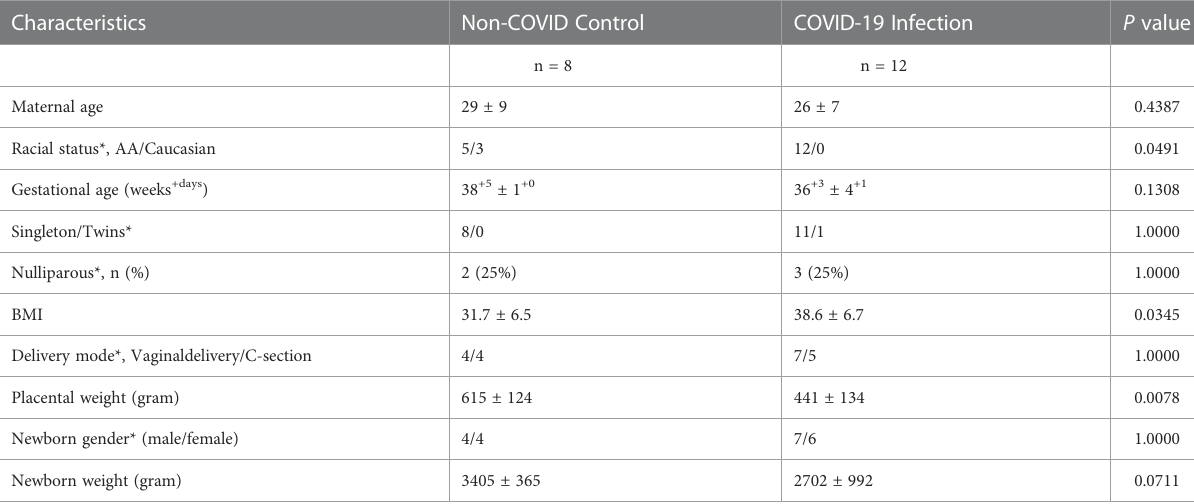
TABLE 1 Demographic data of pregnant women with or without COVID-19 infection from whom placenta was studied.